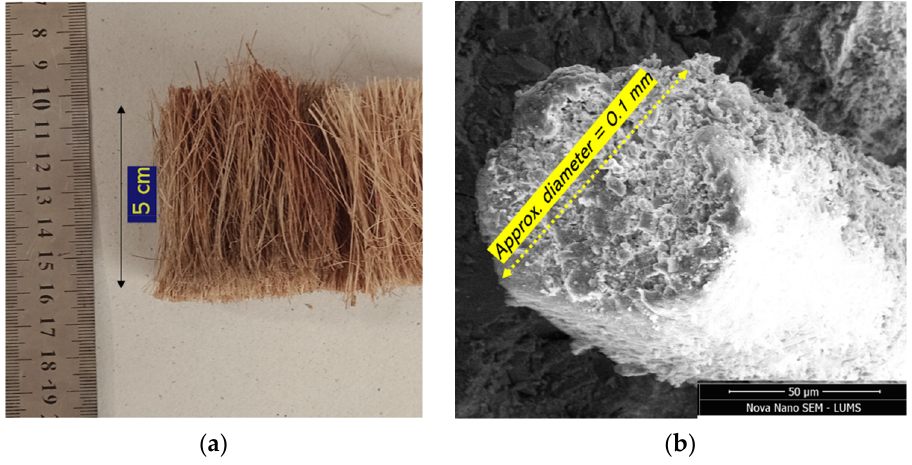
Figure 3. Examination of coir dimensions: ( a ) naked-eye observation; ( b ) SEM observation.